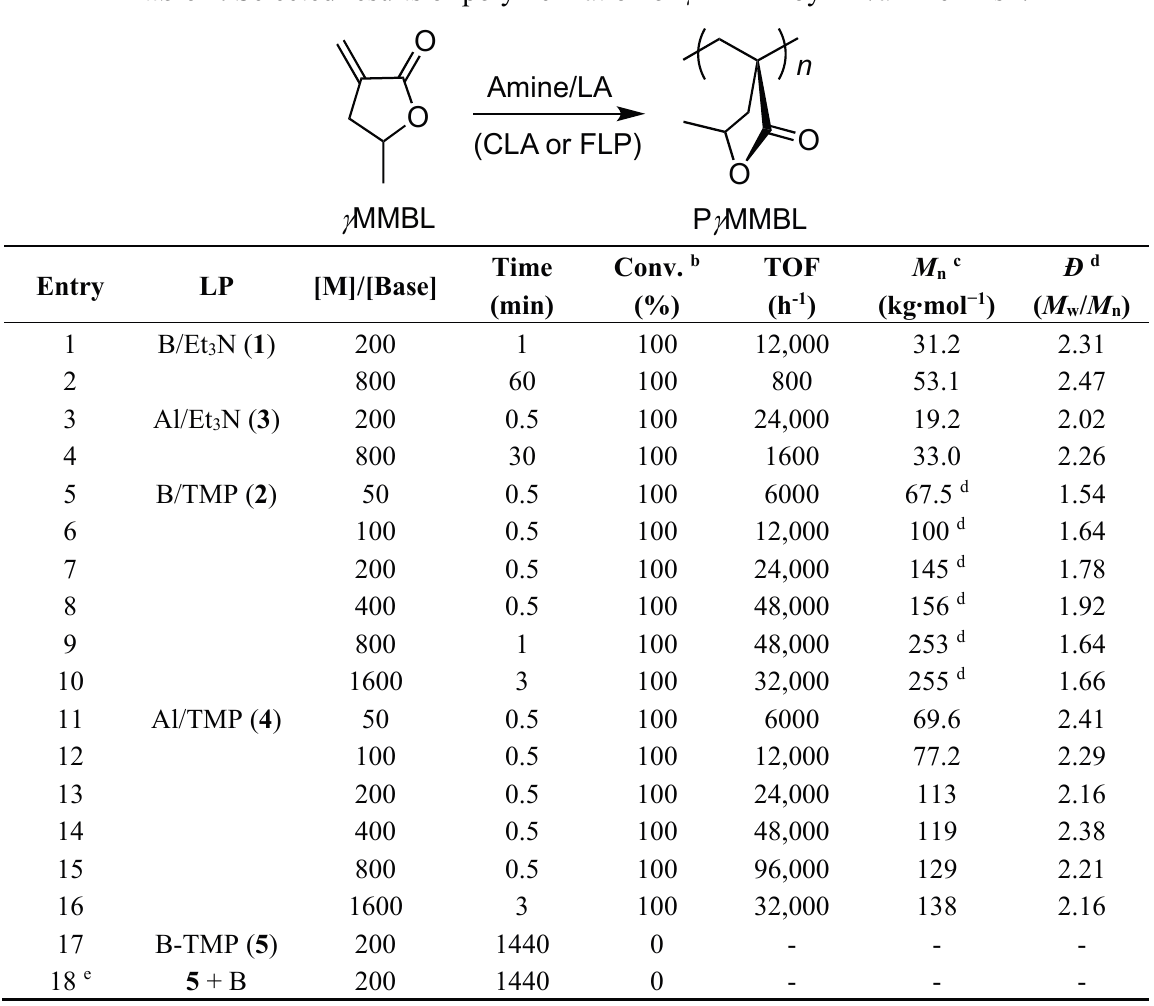
Table 1. Selected results of polymerization of γ MMBL by LA/amine LPs a